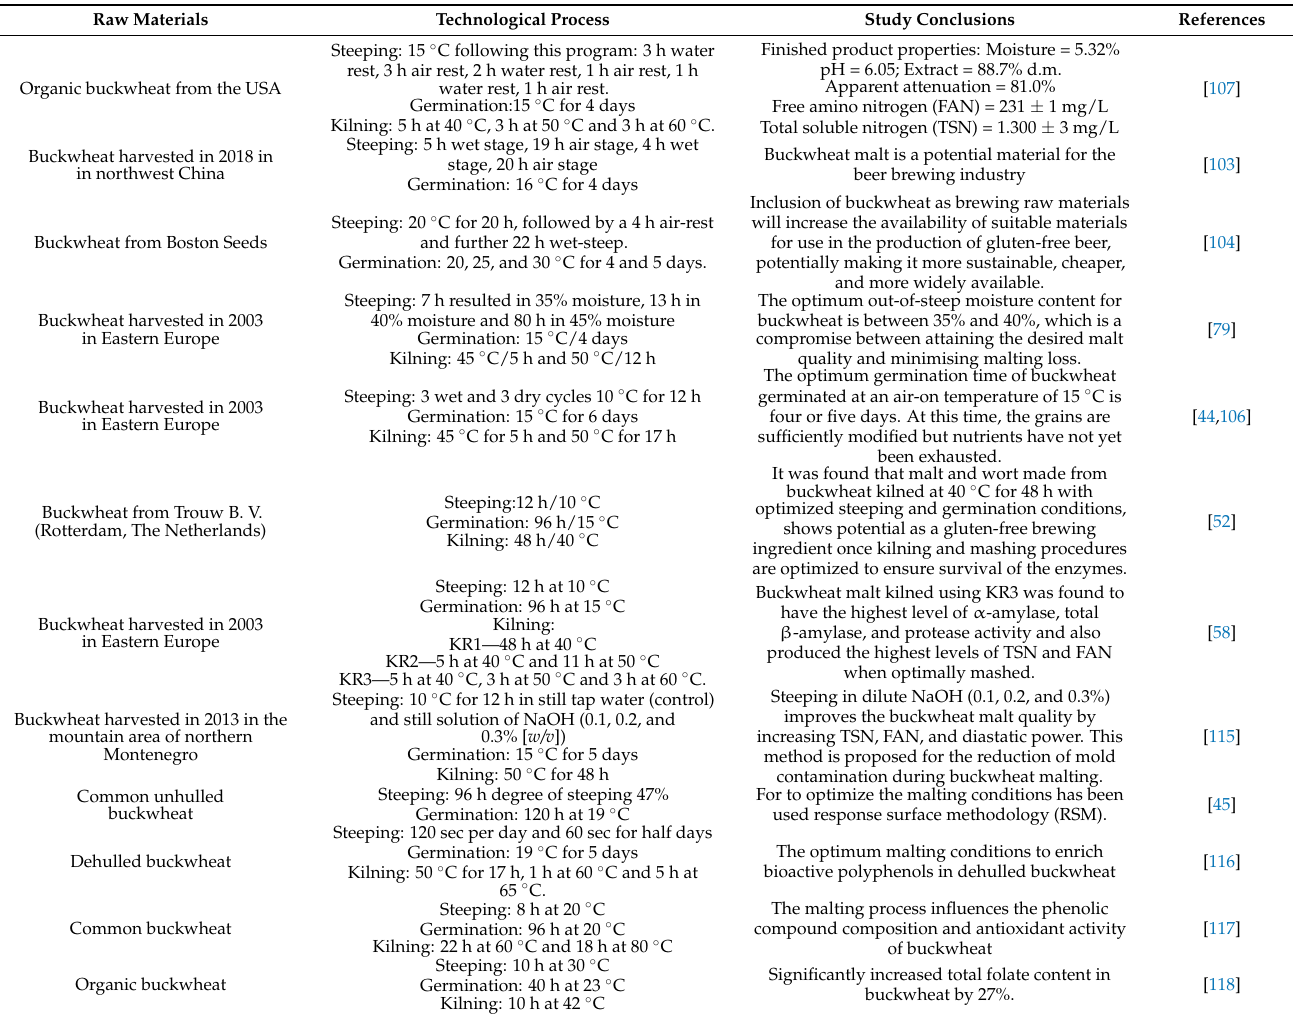
Table 2. Published studies on buckwheat